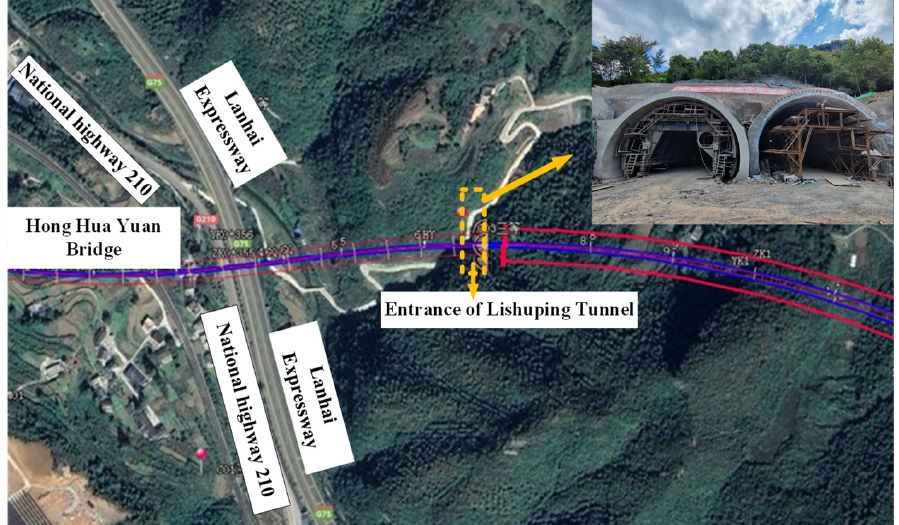
Figure 1. Location of the tunnel and topographic map of the tunnel entrance.